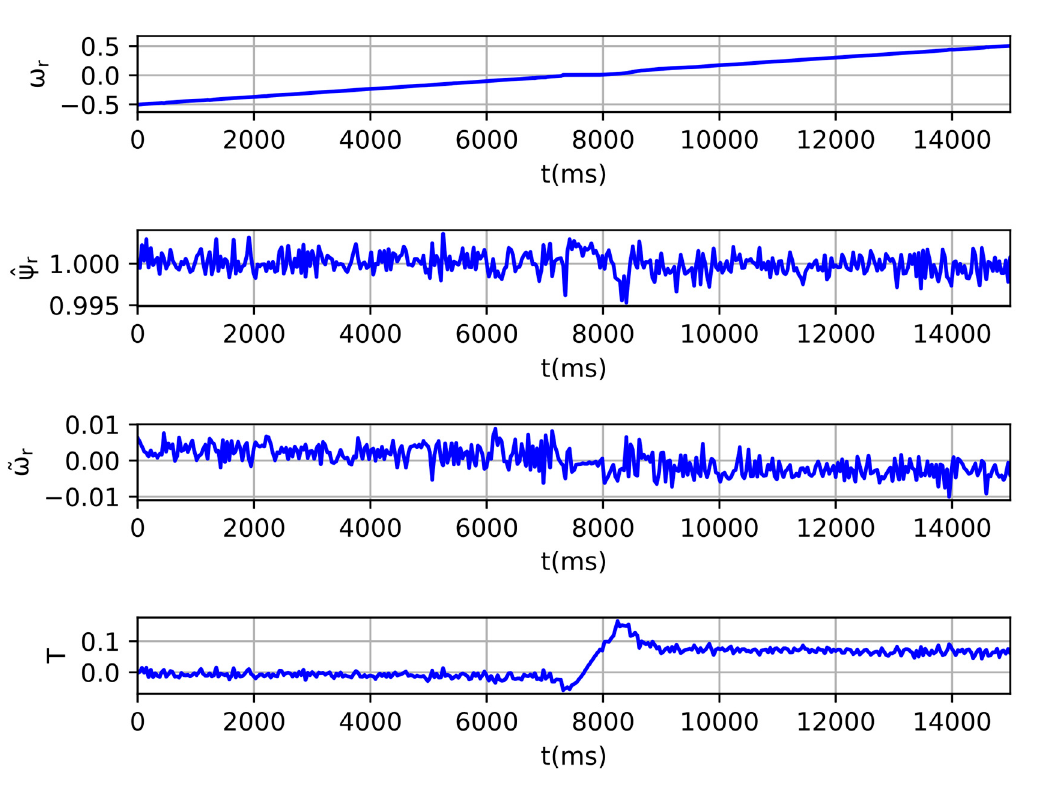
Figure 14. Experimental results during rotor direction change using the open-loop control system.